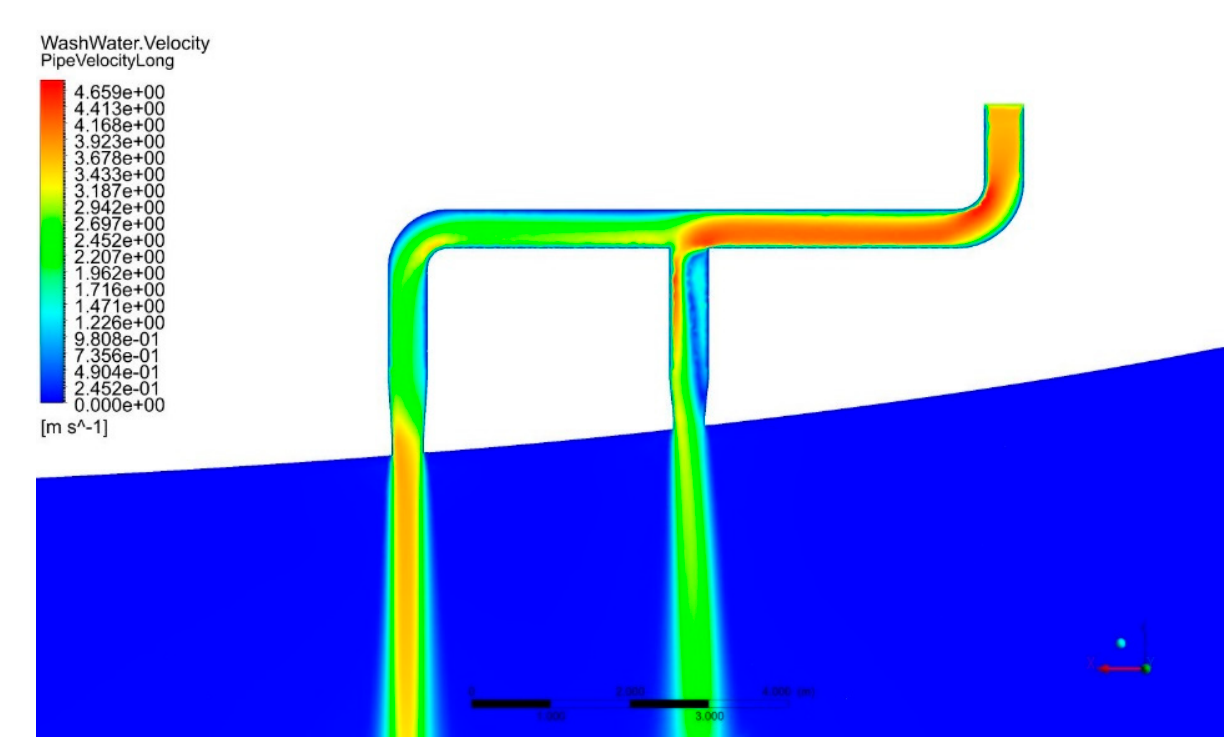
Figure 10. Velocity variation—pipe longitudinal section.